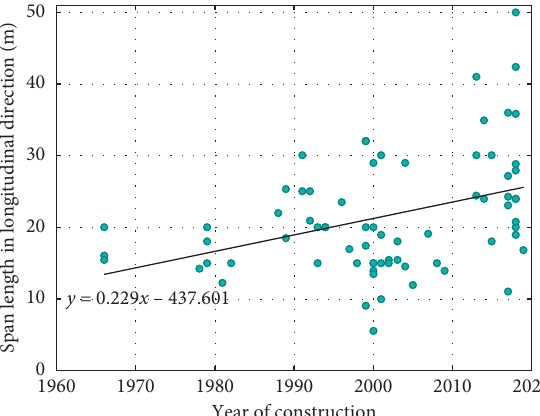
Figure 13: Evolution of span length in the longitudinal direction with the year of